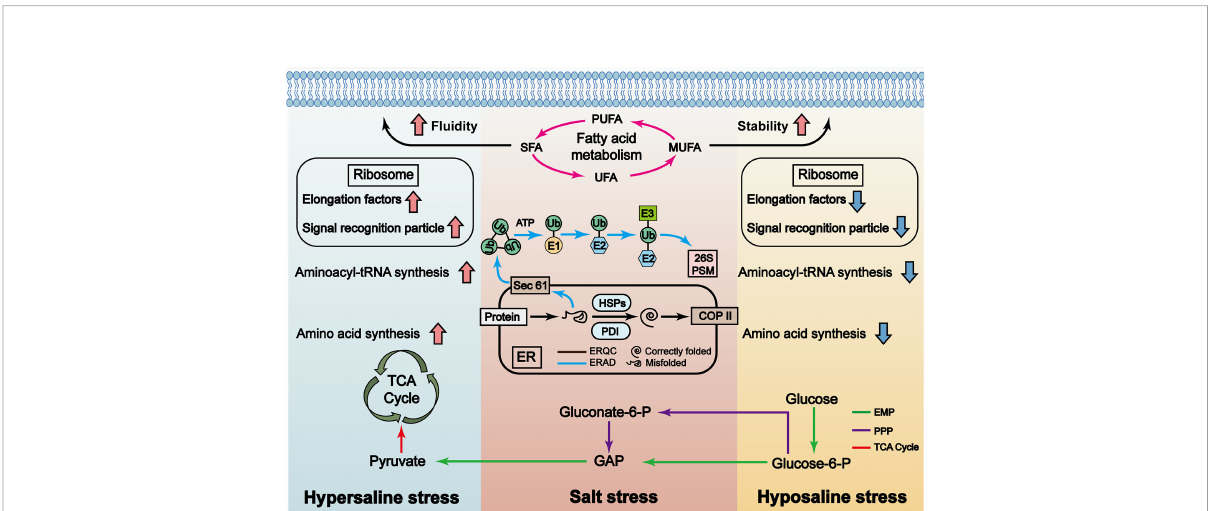
FIGURE 6 Model of P. haitanensis response mechanisms under hypersaline and hyposaline stress. The results of this study show that, in response to salt stress, P. haitanensis will: enhance the pentose phosphate pathway (PPP, purple arrows) to meet the demand for sugar metabolism, intermediates and energy, whether under hypersaline stress or hyposaline stress; enhance the endoplasmic reticulum quality control (ERQC, black) and endoplasmic reticulum-associated degradation (ERAD, blue) systems to maintain protein folding in the endoplasmic reticulum, and remove misfolded proteins to maintain the steady state of the endoplasmic reticulum; actively change the type and content of fatty acids (FAs) to maintain the stability or integrity of cell membranes, and so ensure that vital cellular activities can continue, even under salt stress. The EMP (green arrows) is the main energy supply pathway of P. haitanensis under hyposaline stress, while the TCA cycle (red) is the main functional pathway under hypersaline stress. Hyposaline stress inhibits the synthesis of amino acids and proteins. In contrast, hypersaline stress promotes the synthesis of amino acids and